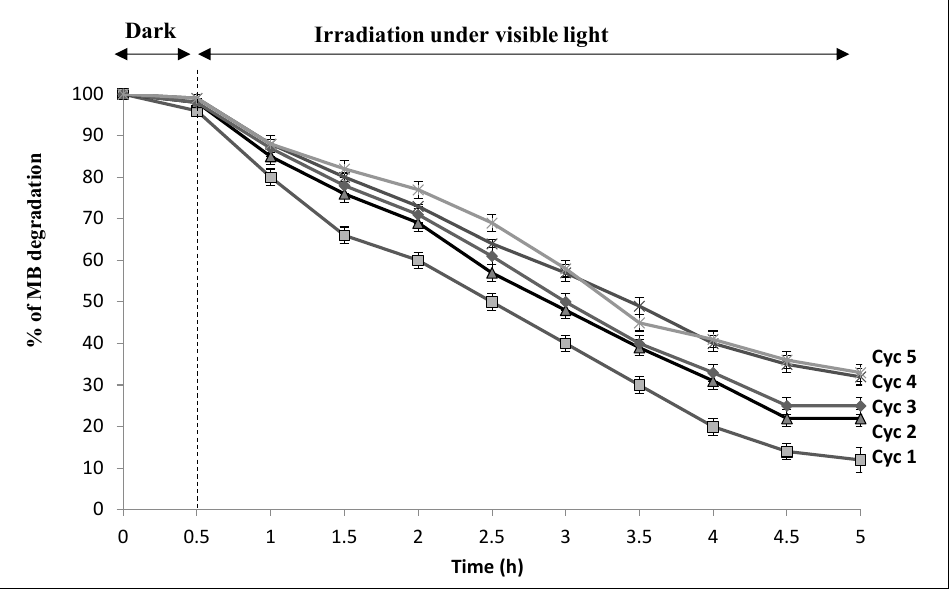
Figure 7. Recycling experiments for five cycles (Cyc) of PAN/goethite CNF for photocatalytic degradation of MB.